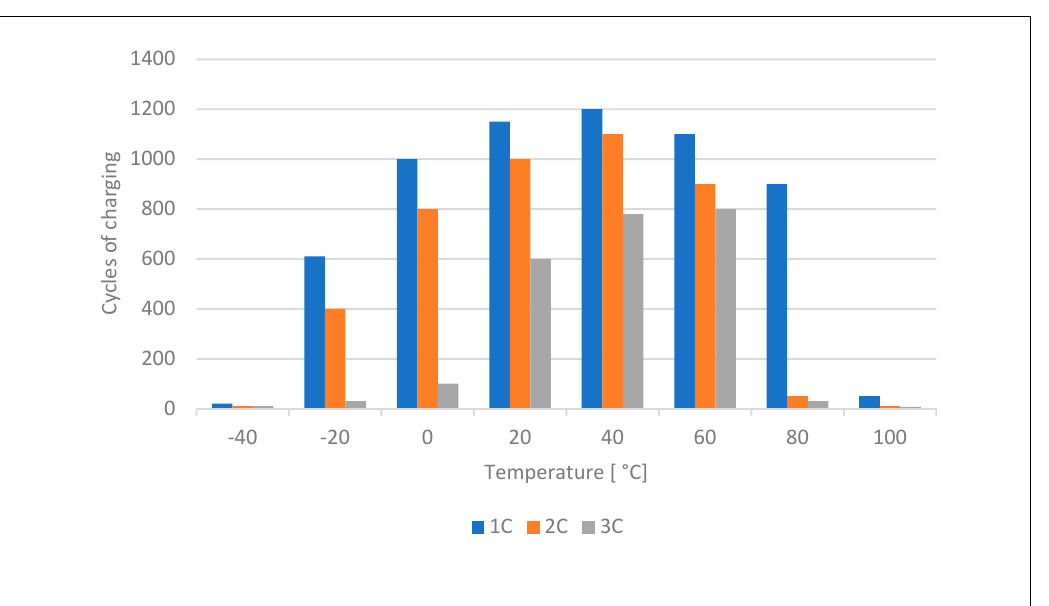
Figure 7. Effects of the charging process characteristics over battery life and temperature [24].